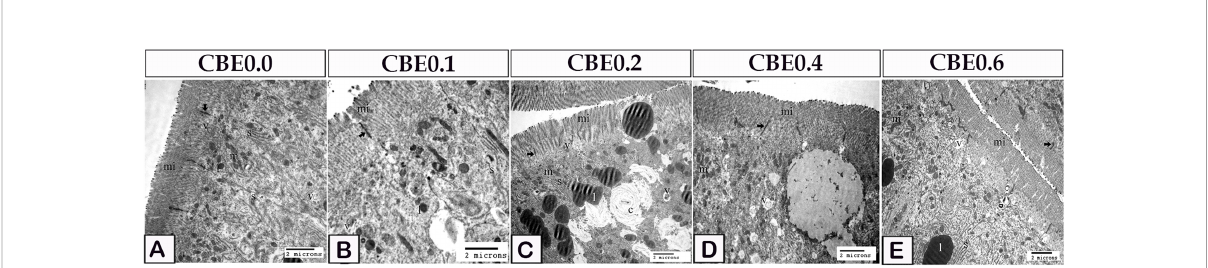
FIGURE 7 Transmission electron micrograph showing microvilli modi fi cations in response to feed on different doses of CBE. (A) The smooth endoplasmic reticulum (s), lipid (l), mitochondria (m), and endocytotic vesicles (v) were seen in control enterocytes. Note the occulden junction (arrow), as well as the microvilli (mi). (B) Microvilli (mi) height increased in group I enterocytes. Endocytotic vesicles (v), lipid (l), mitochondria (m), and smooth endoplasmic reticulum occulden junction (arrow). (C) Microvilli height was higher in group II enterocytes than in group (I) Concentric lamellar bodies (c) composed of smooth endoplasmic reticulum which enclosed the lipid droplet. Note the smooth endoplasmic reticulum (s), lipid (l), mitochondria (m), (s) endocytotic vesicles (v). occulden junction (arrow). (D) When compared to group II, enterocytes in group IV had higher microvilli height. Note the smooth endoplasmic reticulum (s), lipid (l), mitochondria (m), endocytotic vesicles (v). occulden junction (arrow). (E) Microvilli height in group VI enterocytes was higher than in group IV. Note the smooth endoplasmic reticulum (s), lipid (l), mitochondria (m), endocytotic vesicles (v). occulden junction (arrow).